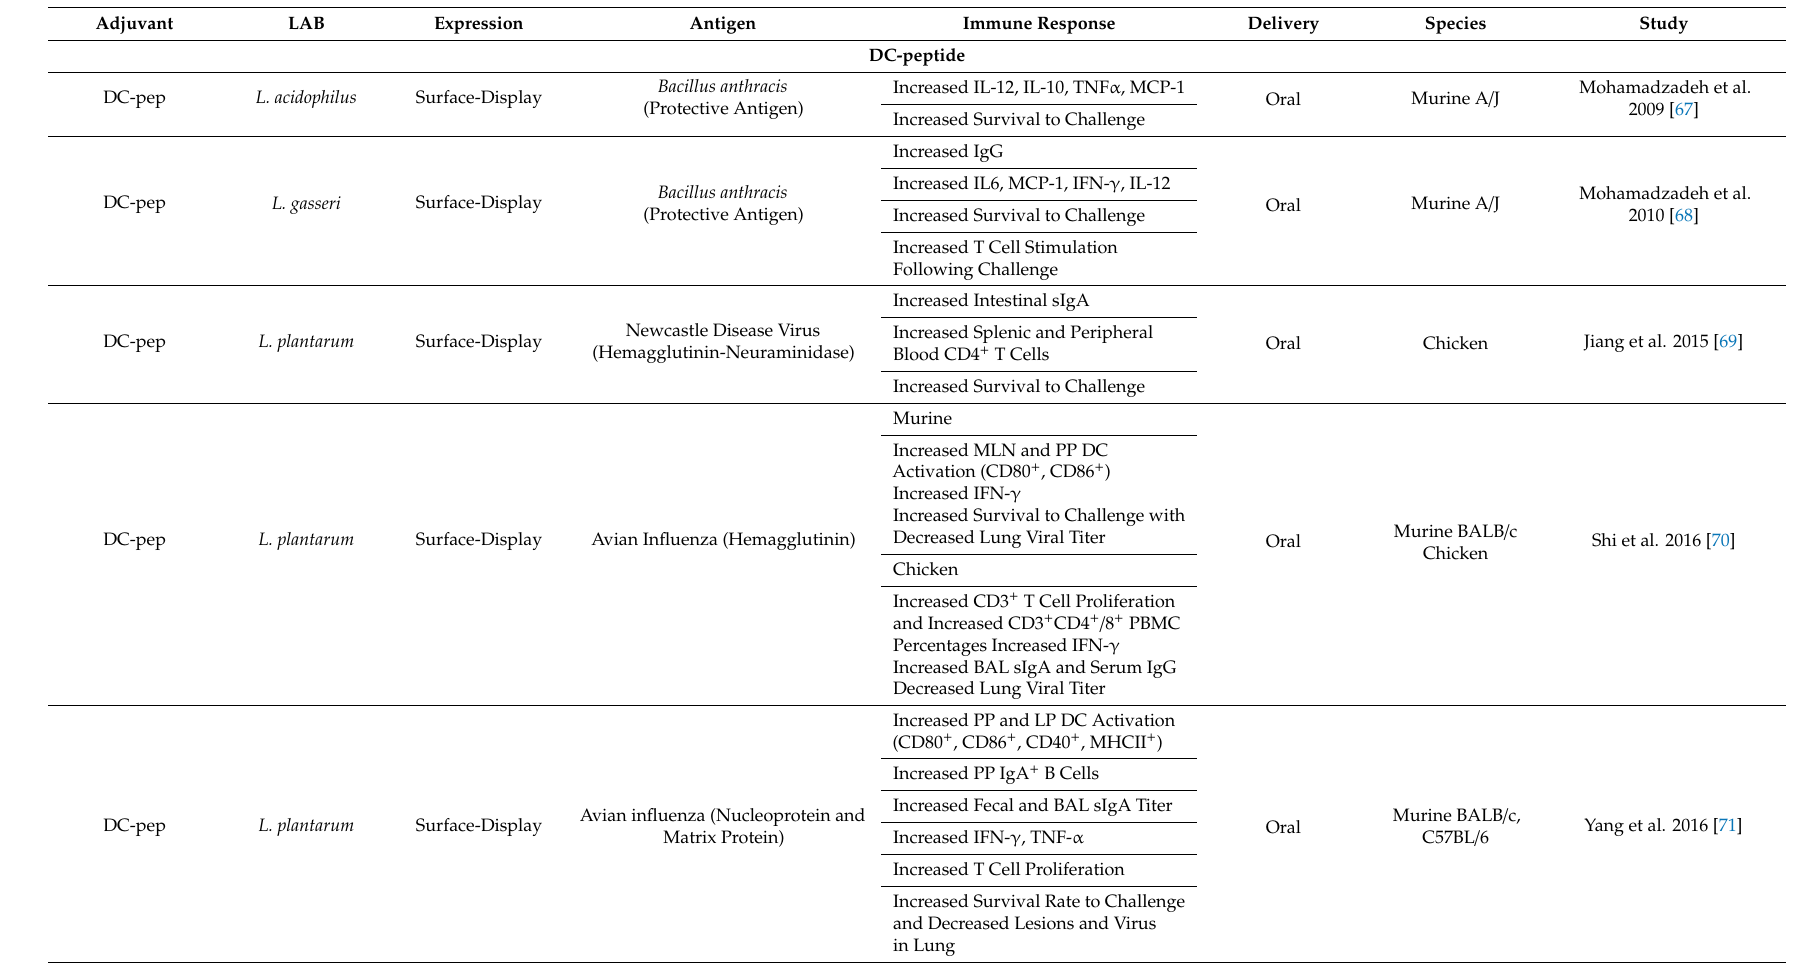
Table 2. Dendritic cell (DC) adjuvant strategies for lactic acid